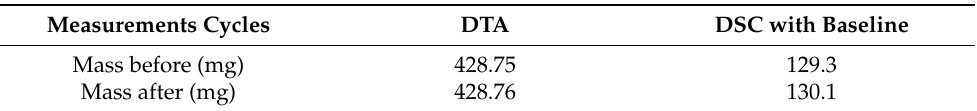
Table 2. Weight changes of differential scanning calorimetry (DSC) and differential thermal analysis (DTA) samples showing negligible mass